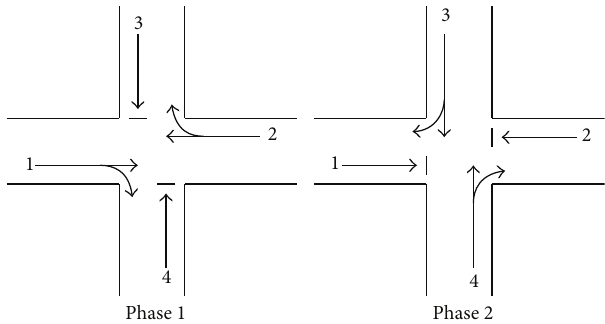
Figure 1: Intersection with four approaches and two-phase signal.